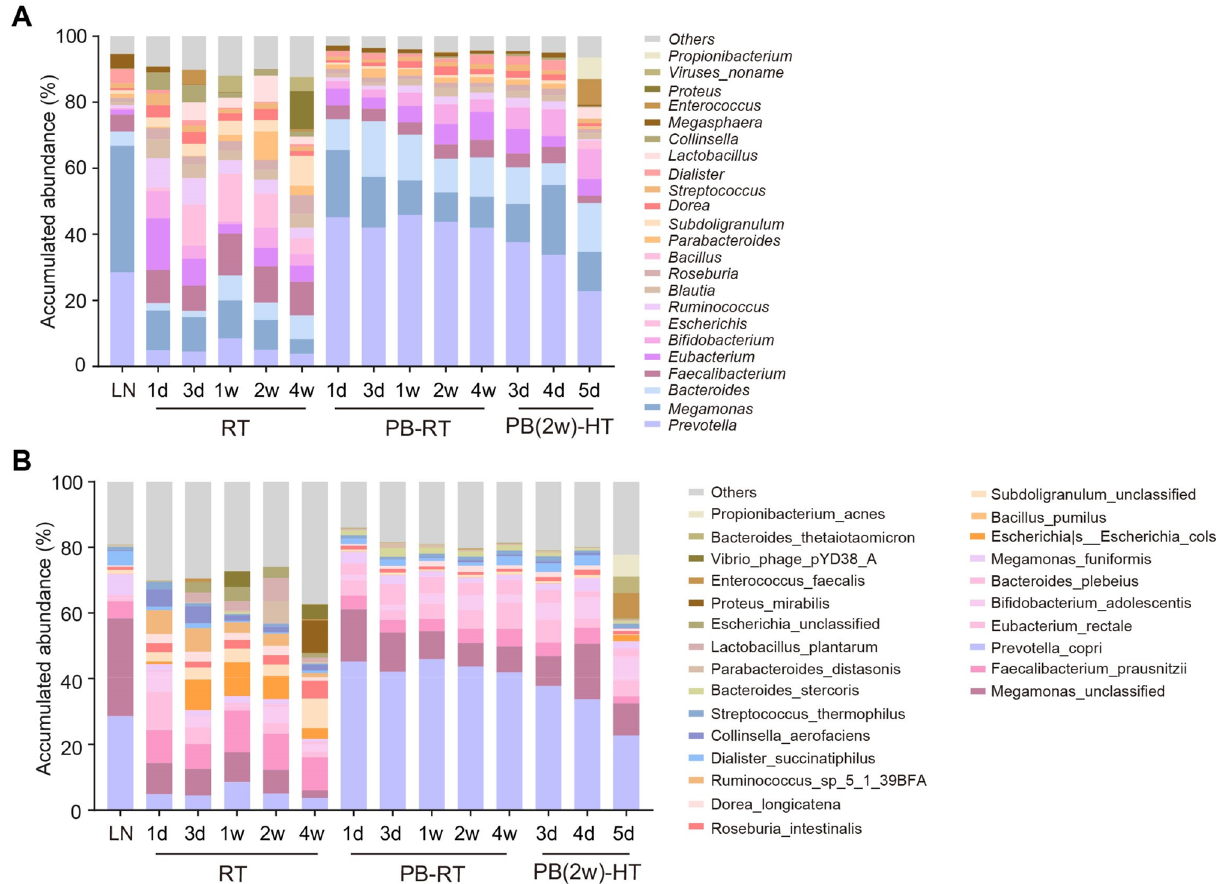
Figure 3. Taxonomic profile of fecal microbiota in human fecal samples stored with PB buffer. The relative abundance profile of microbial communities at the genera ( A ) and species ( B ) level. N = 3